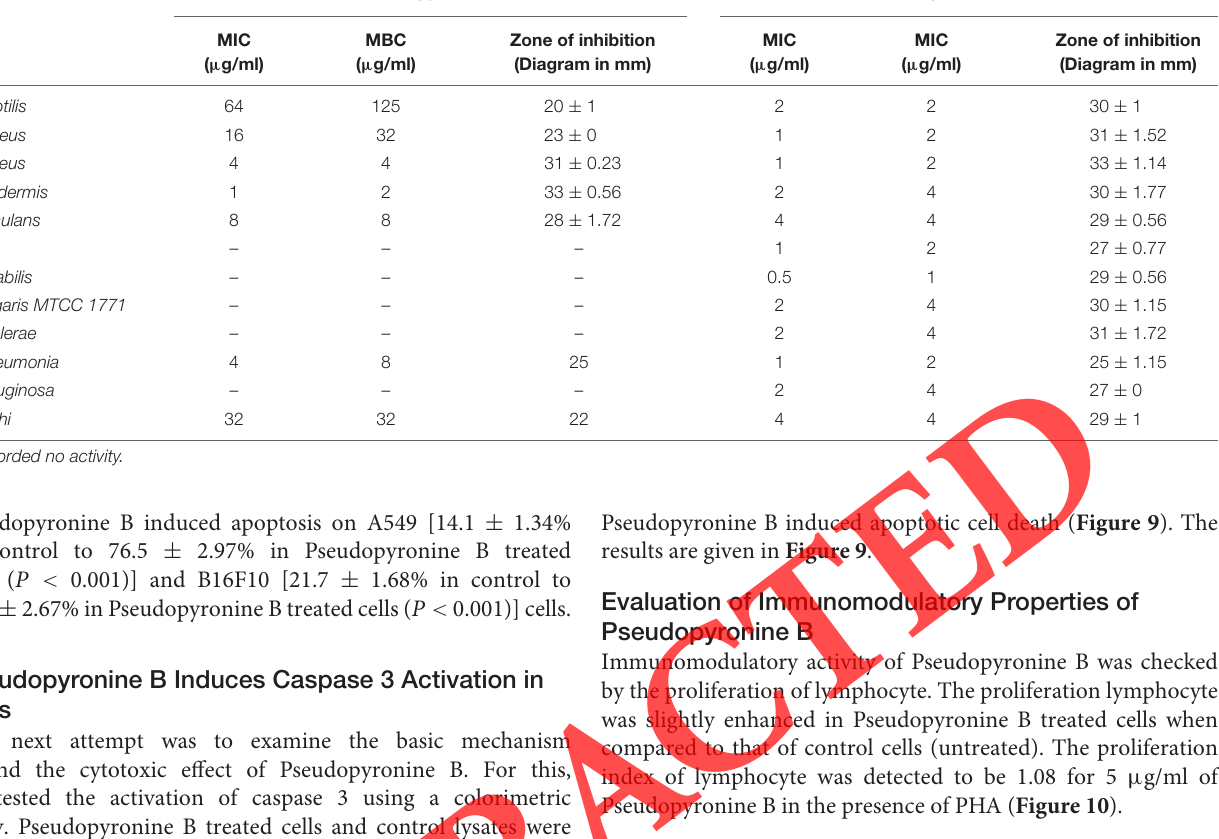
TABLE 1 | Antibacterial activity of Pseudopyronine B. Test bacteria